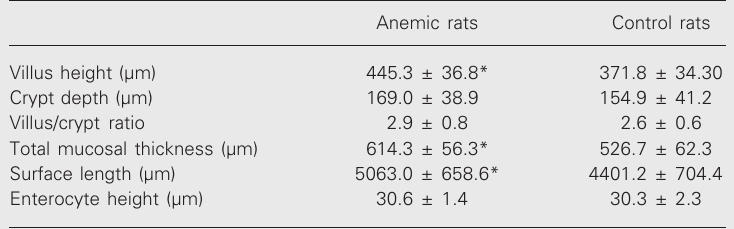
Table 2. Jejunal morphometry of rats with iron-deficiency anemia.